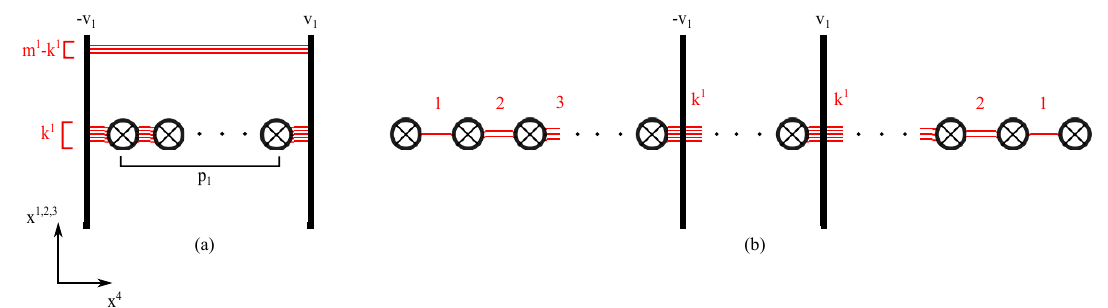
Figure 10 . This (cid:12)gure shows the two Hanany-Witten frames of our brane con(cid:12)guration that we are considering: (a) the standard frame and (b) the Hanany-Witten \dual magnetic" frame (with the unbubbled monopoles